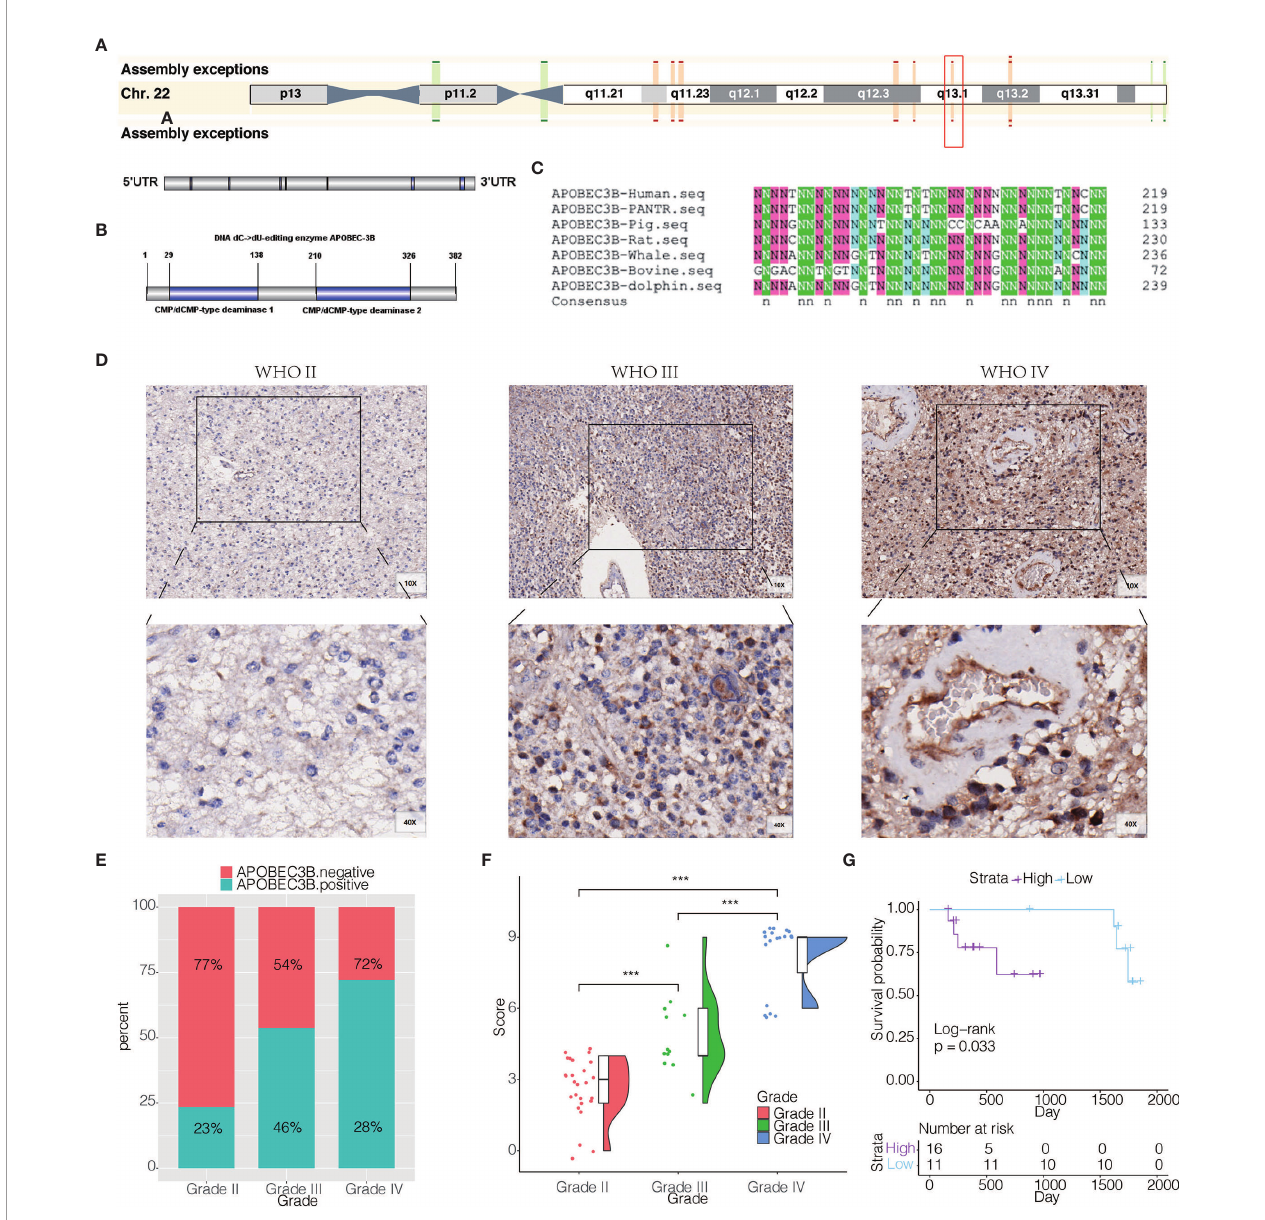
FIGURE 2 | APOBEC3B expression is elevated in aggressive glioma and related to poor prognosis. (A) Chromosome localization and gene structure of APOBEC3B in human. (B) Structure of APOBEC3B. (C) Comparison of protein sequences encoded by APOBEC3B among seven different species. (D) Representative images of IHC staining for APOBEC3B in different pathological grades of gliomas [WHO II (27), WHO III (12), WHO IV (19)]. (E) Quanti fi cation of APOBEC3B IHC staining regarding the positive rate. (F) Quanti fi cation of APOBEC3B IHC staining regarding the H-score. (G) Overall survival based on high vs low expression of APOBEC3B in glioma patients (n = 27). The patients were strati fi ed according to the H score of APOBEC3B in IHC staining. The H score has the range of 0 – 12. High group was de fi ned as expression intensity >=6. Low group was de fi ned as expression intensity <6. NS, Not Statistically Signi fi cant; *P < 0.05; **P < 0.01; ***P < 0.001; ****P <